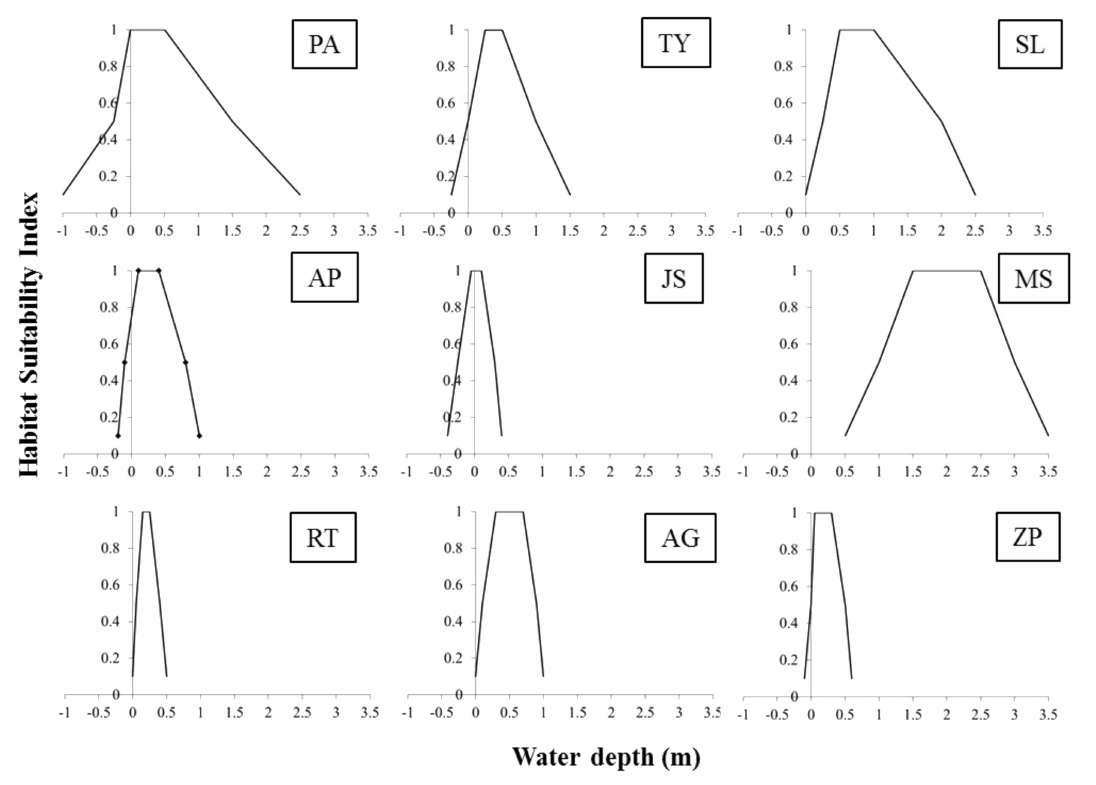
Figure 4. Habitat suitability curves in relation to water depth for the selected macrophytic indicator taxa: (PA) Phragmites australis , (TY) Typha spp., (SL) Schoenoplectus lacustris , (AP) Alisma plantago-aquatica , (JS) Juncus subnodulosus , (MS) Myriophyllum spicatum , (RT) Ranunculus trichophyllus , (AG) Alisma gramineum , and (ZP) Zannichellia palustris